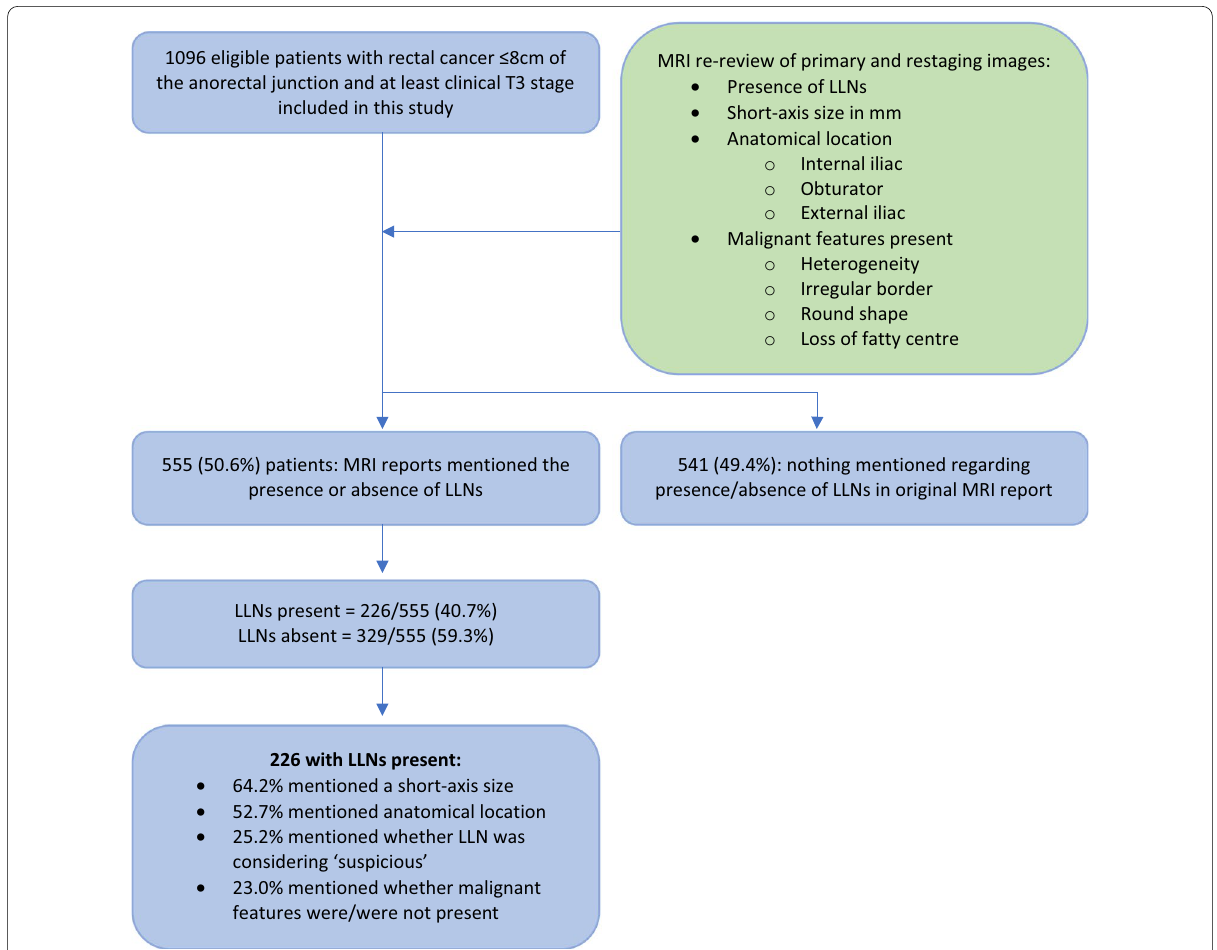
Fig. 2 Flowchart of results according to MRI